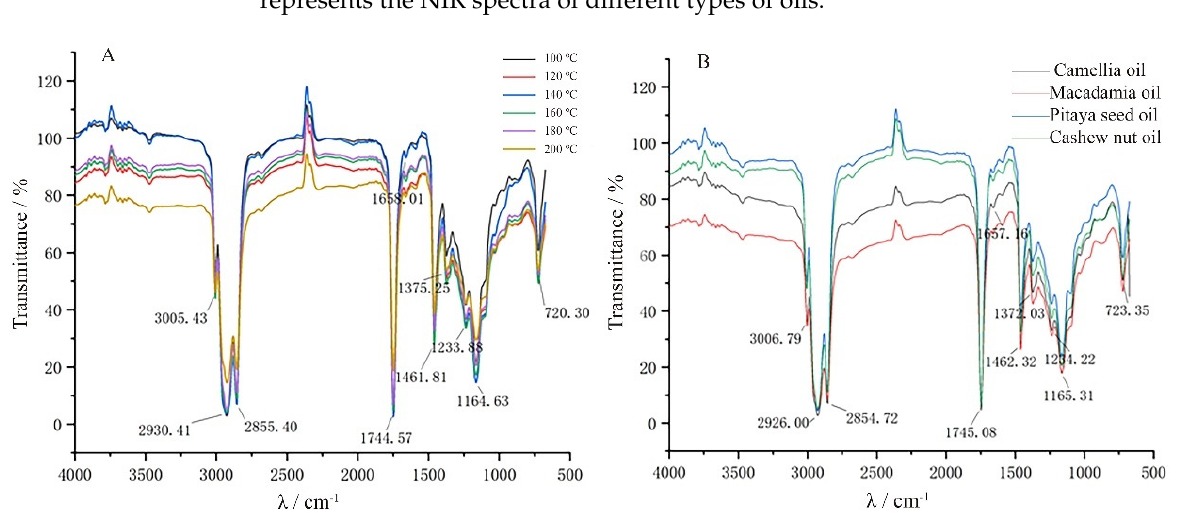
Figure 2. NIR spectral characteristics of cashew nut kernel oil. ( A ) represents the NIR spectral characteristics of CNKO at different pressing temperatures; ( B ) represents the NIR characteristics of CNKO compared with other oils.